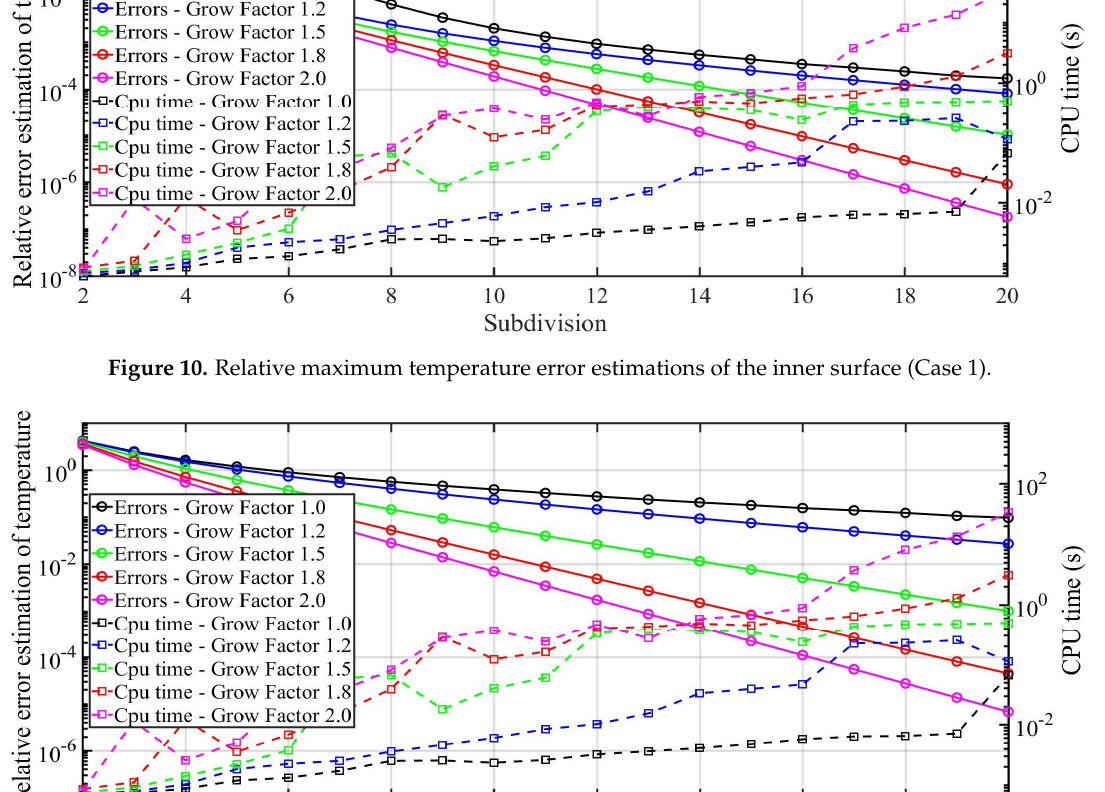
Figure 11. Relative maximum temperature error estimations of the outer surface (Case 1).